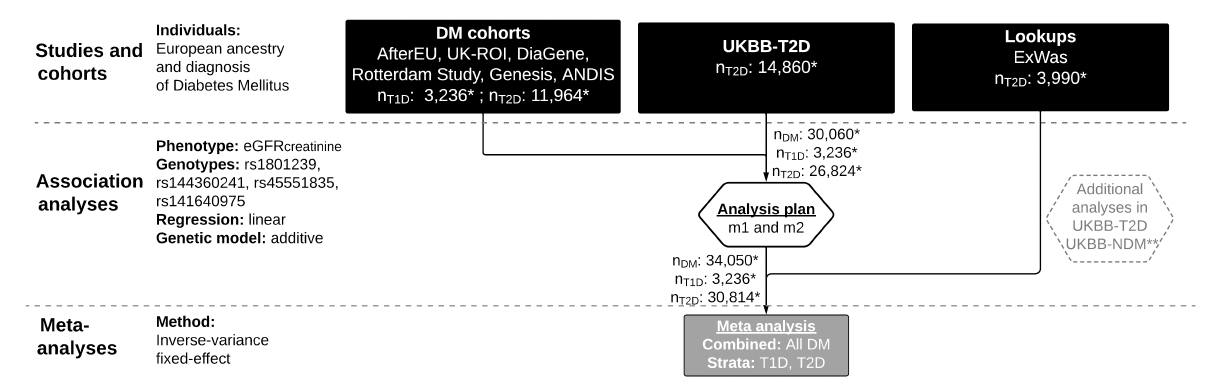
FIGURE 1 Flow chart of SNV-eGFRcreatinine meta-analyses in Diabetes. UKBB, UK Biobank; T2D, Type 2 diabetes; DM, diabetes mellitus; T1D, Type 1 diabetes; NDM, without diabetes mellitus; SNV, single nucleotide variant; eGFRcreatinine, Estimated glomerular fi ltration rate, natural log-transformed; PCs, Principal components of population structure; HbA1C, hemoglobin A1C; SBP, Systolic blood pressure; m1: model 1 (eGFRcreatinine ~ genotype + sex + age + 0-10 PCs); m2: model 2 (m1 + HbA1c + SBP + diabetes duration); * Sample sizes (n) re fl ect the maximal number of individuals (out